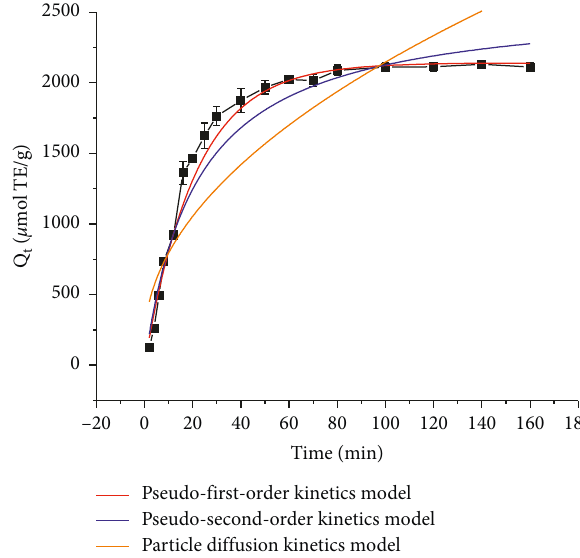
Figure 3: Adsorption kinetics of antioxidants on